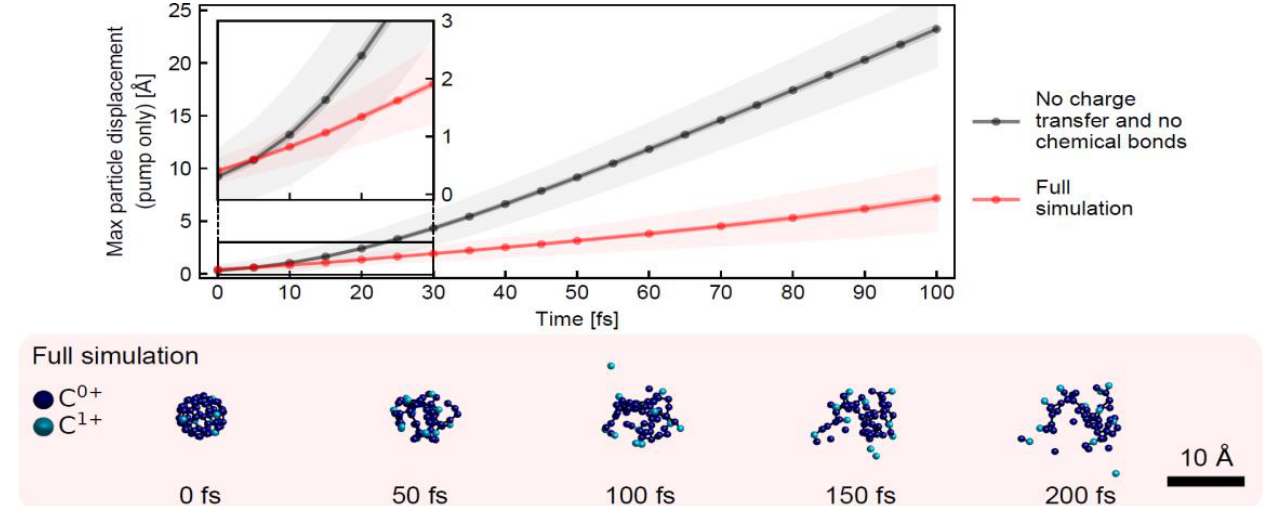
Figure 4. Movie snapshots of the real-space and real-time simulation dynamics of C 60 13+ induced by XFEL pulse.